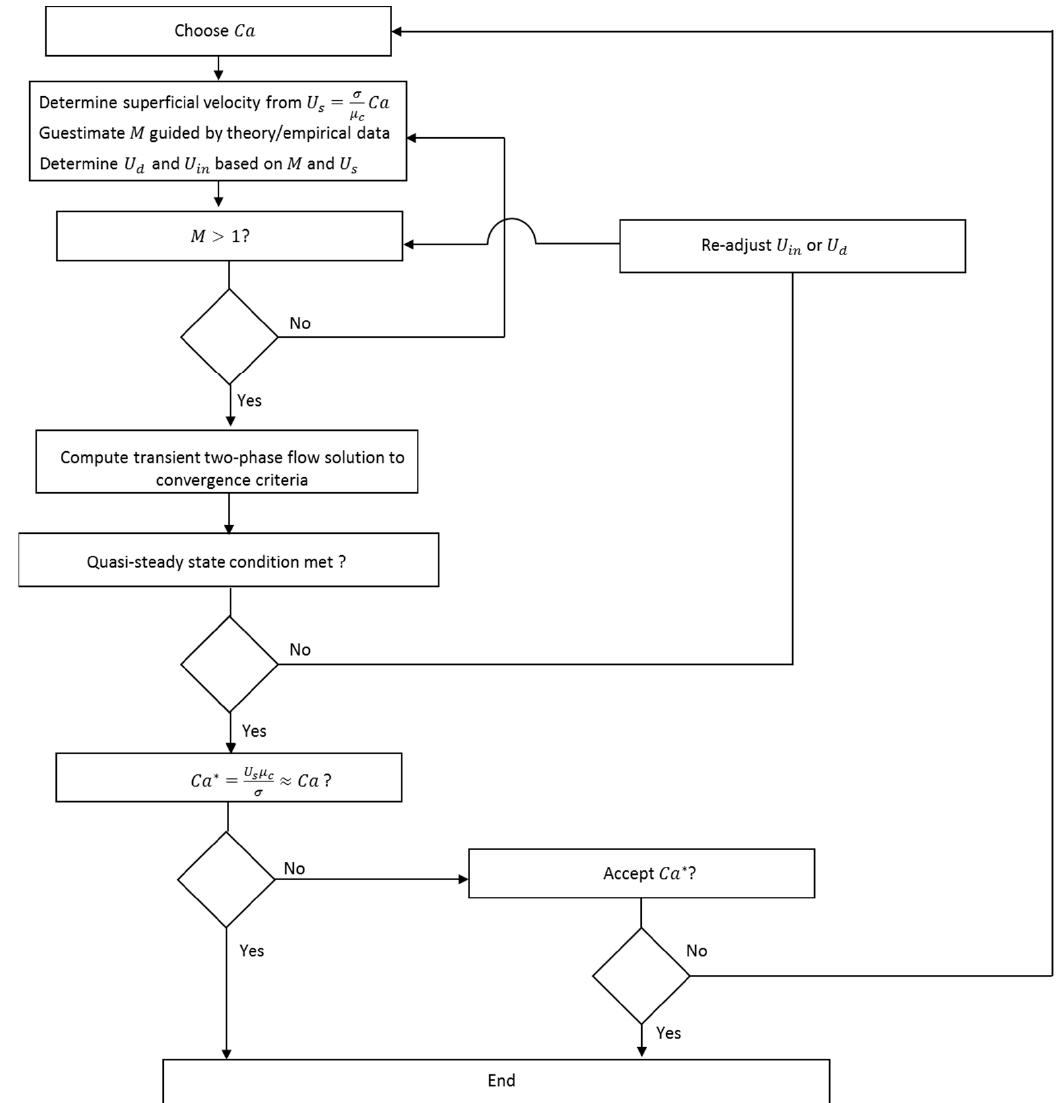
Figure 4. Flow diagram for the iteration process towards quasi-steady-state of the flow solution.